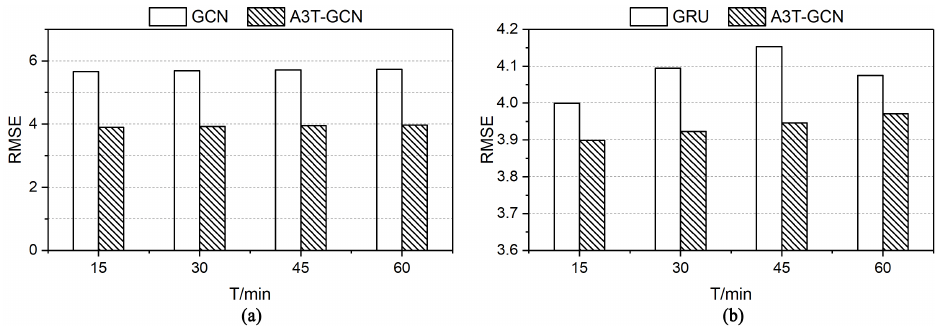
Figure 2. SZ-taxi: Effectiveness of modeling both spatial and temporal dependencies. ( a ) The RMSE comparison between the A3T-GCN and the GCN (captures spatial features only). The outperformance of the A3T-GCN under various prediction horizons verifies the effectiveness of the A3T-GCN in capturing additional temporal features compared with the GCN. ( b ) The RMSE comparison between the A3T-GCN and the GRU (captures temporal features only). The outperformance of the A3T-GCN under various prediction horizons verifies the effectiveness of the A3T-GCN in capturing additional spatial features compared with